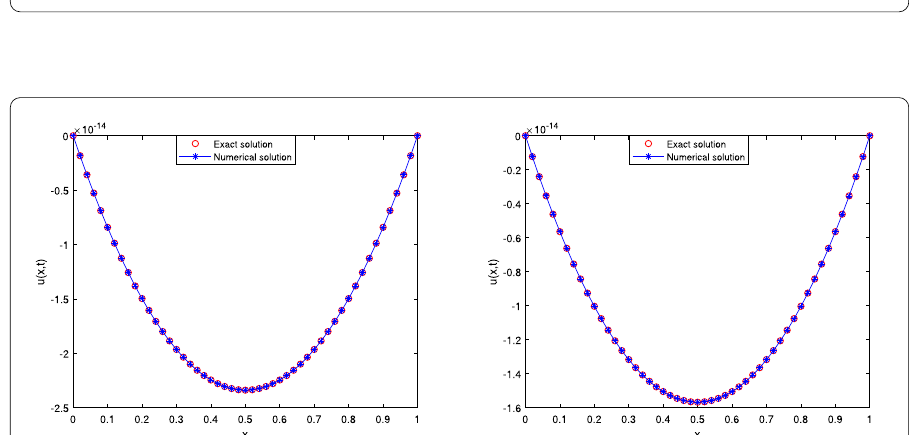
Figure 4 Exact and approximate solutions for Example 6.1 in the case of n = 5 with fractional values α = 1.8, β = 0.8 (left), α = 1.6, β = 0.8 (right) with φ ( h ) = 2sin( h /2), h = 2.5 × 10 –4 , and T =